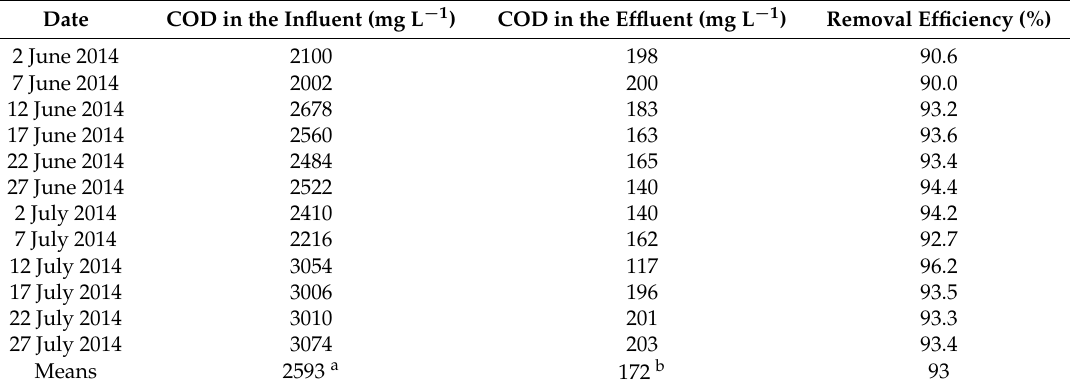
Table 2. Efficiency of a trickling filter in removing COD from the effluent of an anaerobic digester.